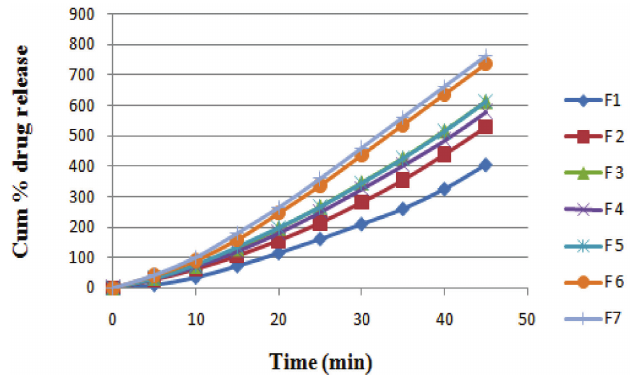
FIGURE 2 - Zero order release kinetics plot.